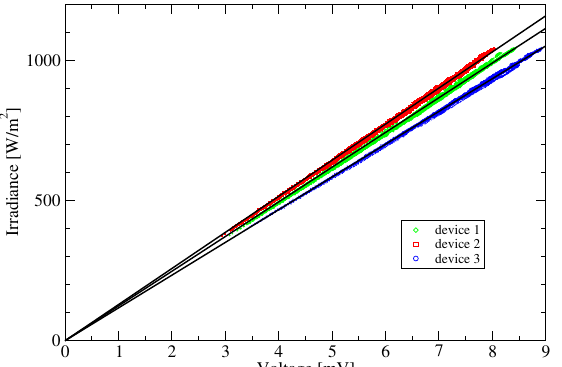
Figure 4. Results for three working class pyrheliometers used to collect clear sky solar irradiance data from 16 May 2013 to 12 August 2013. Sampling rate was 1 hertz and data were processed into one minute averages. A total of 14914 data points are included in the data set. The solid lines are given by linear regression of P = α i × v to the measured data for each of the three